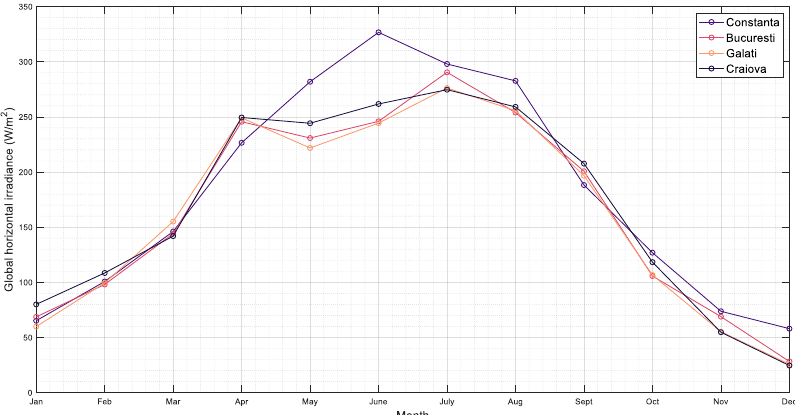
Figure 11. GHI for four locations in Romania from high-potential areas.